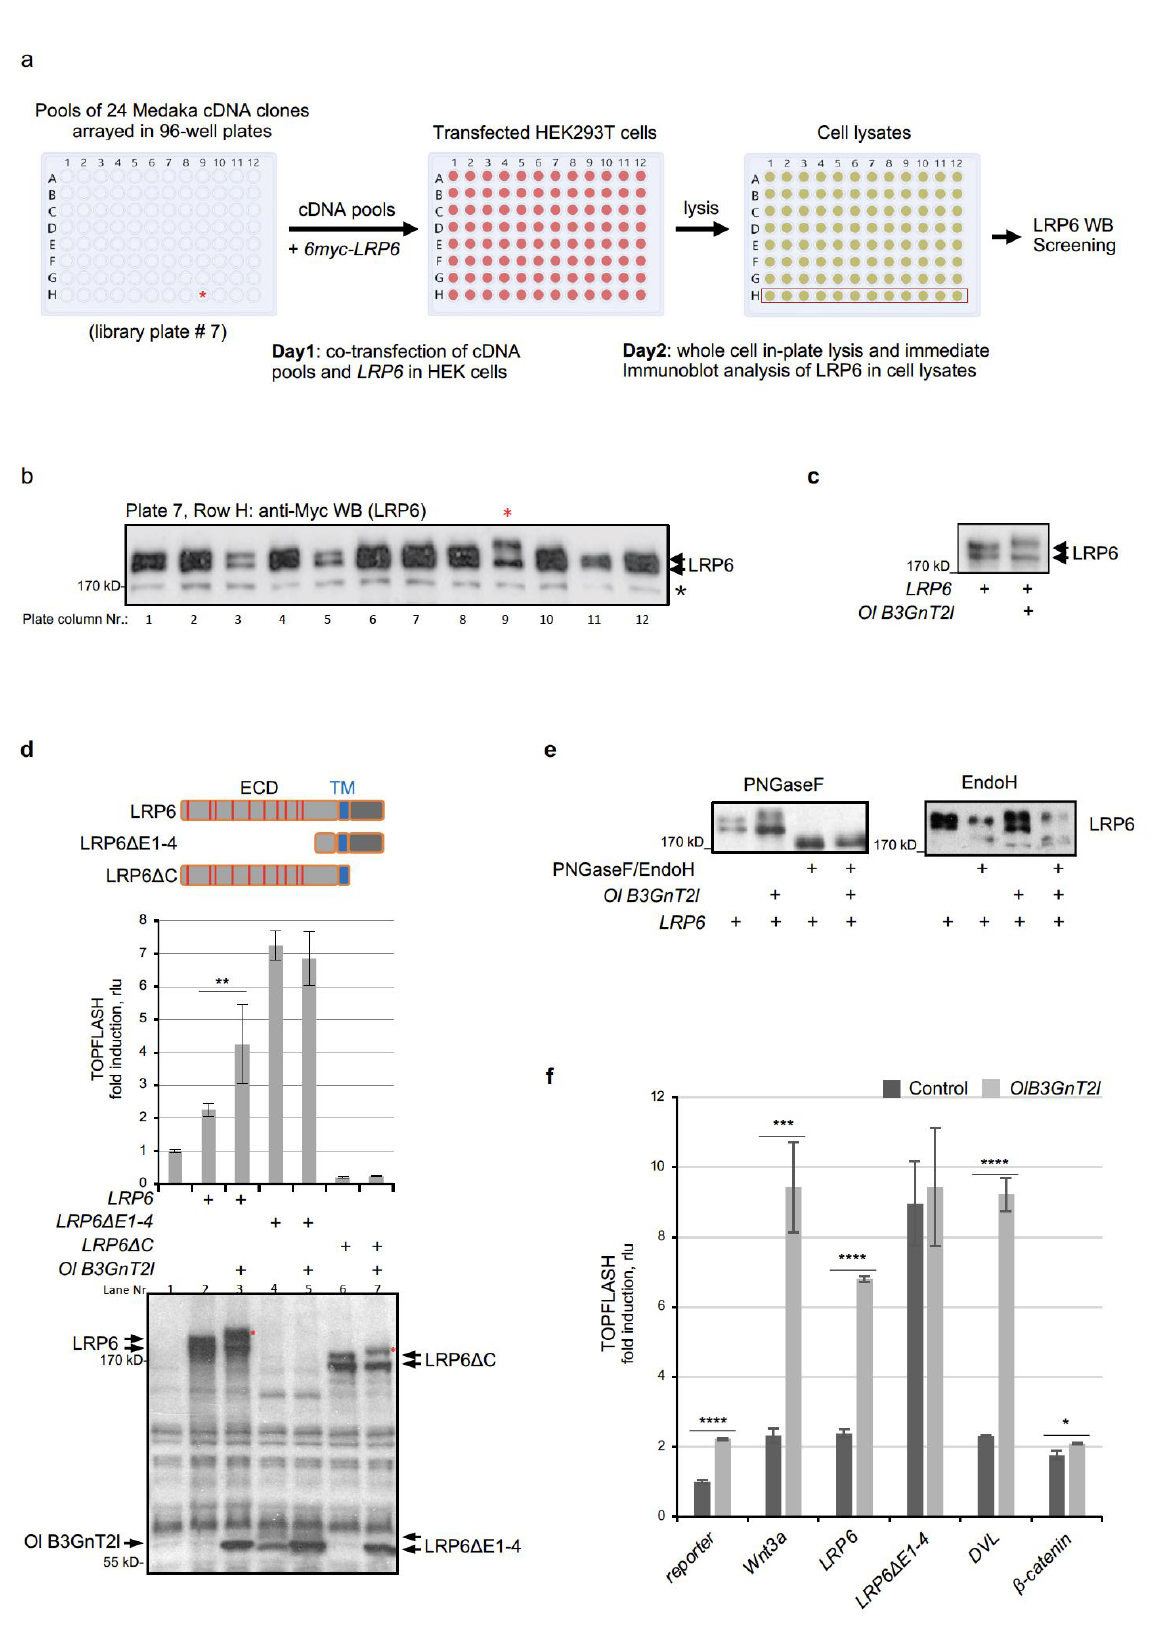
Figure 1. Identification of medaka B3GnT2-like glycosyltransferase as a novel LRP6 modifier. ( a ) Schematic overview of cell culture-based expression screening using pools of 24 medaka ( Oryzias latipes, Ol )